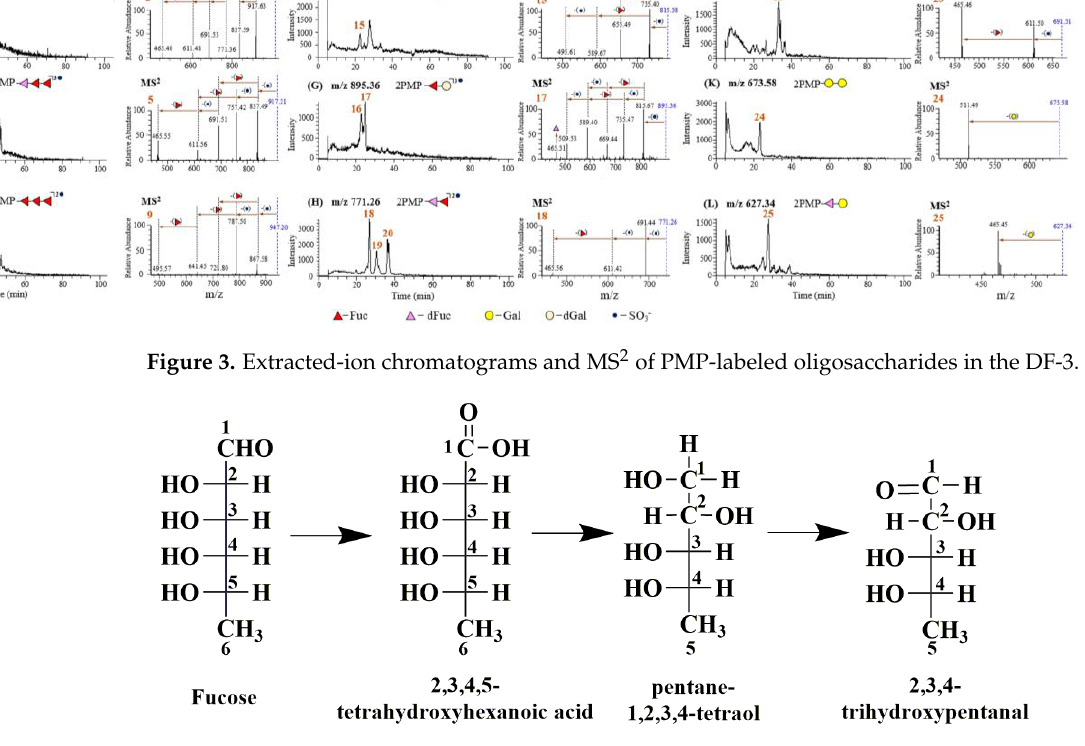
Figure 4. The chemical structure change of fucose during photocatalytic degradation reaction.